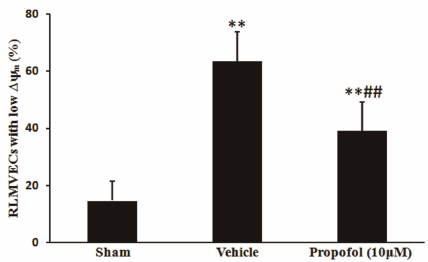
Figure 8. Effect of propofol on burn serum-induced mitochondrial dysfunction. Data are reported as % of sham values. The intracellular ATP level of cells was significantly decreased in the vehicle group compared with sham cells. Propofol pretreatment significantly increased the intracellular ATP content. Data are reported as means±SD (n=5 in each group). **P , 0.01, compared to the sham group; ## P , 0.01 compared to the vehicle group (one- way ANOVA).